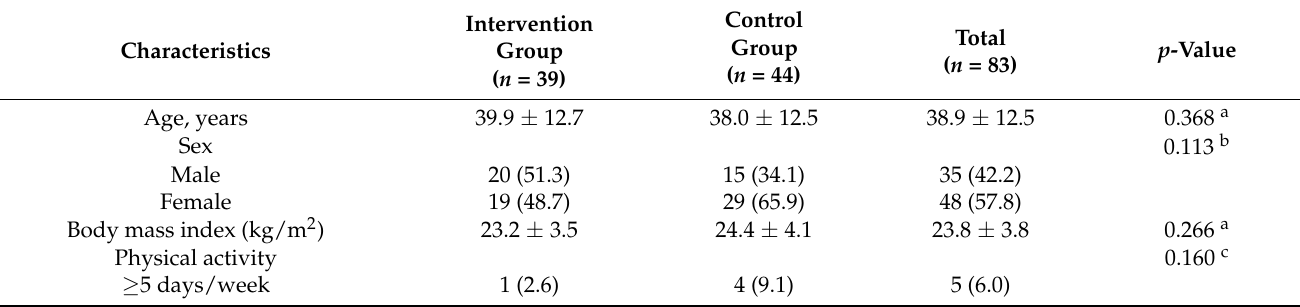
Table 1. Baseline characteristics of study